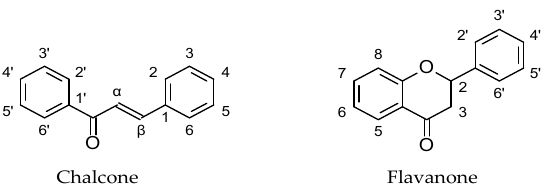
Figure 1. Structure of chalcone and flavanone.